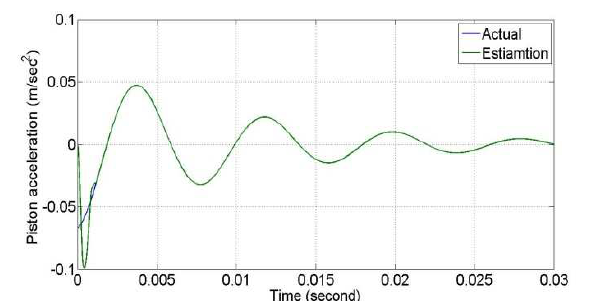
estimation (cid:157)(cid:5) ¡